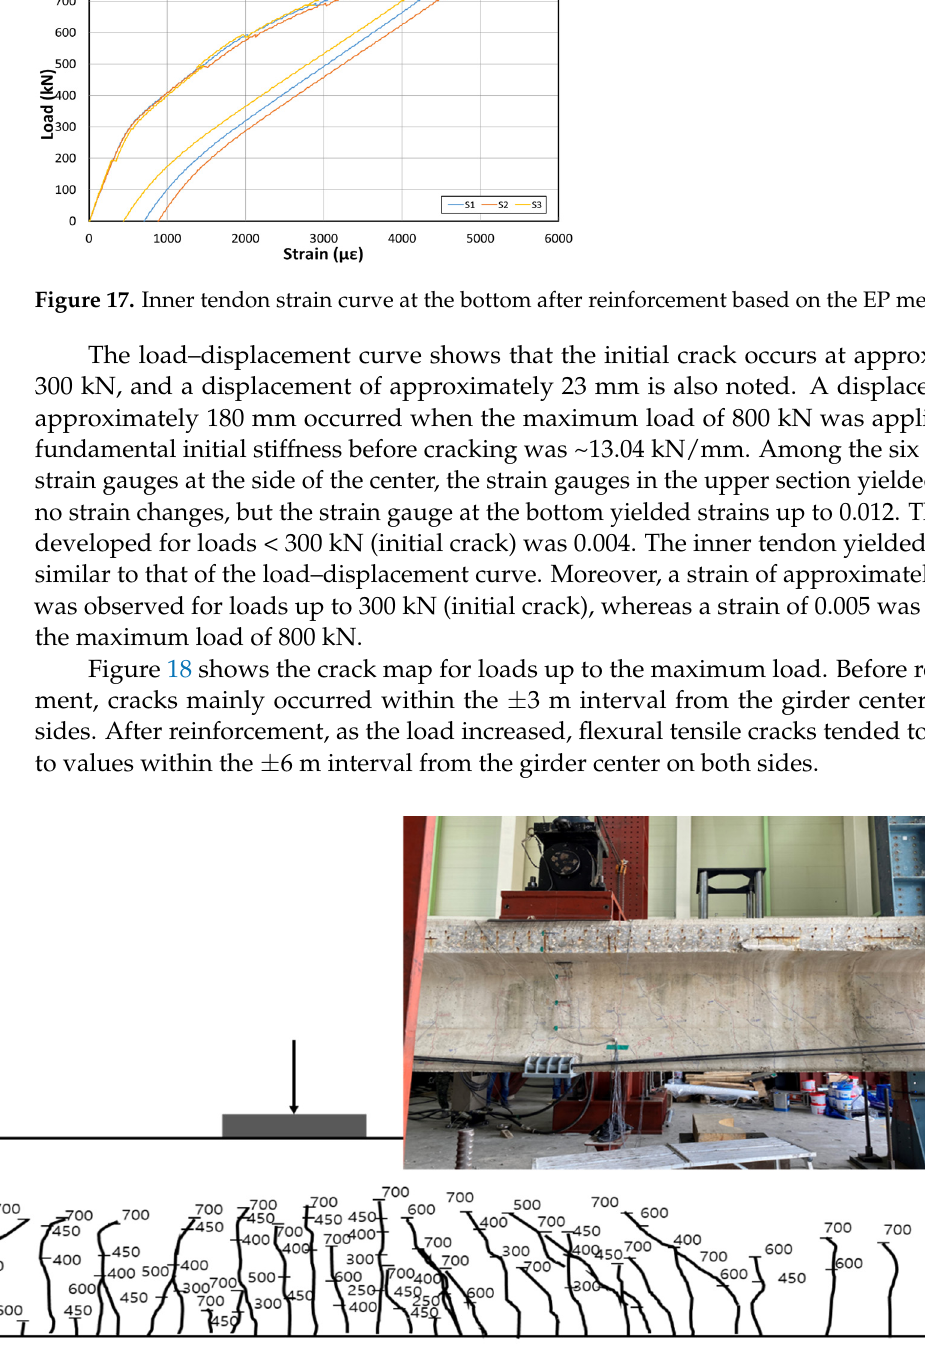
Figure 16. Concrete strain curve at the center after reinforcement based on the EP method.